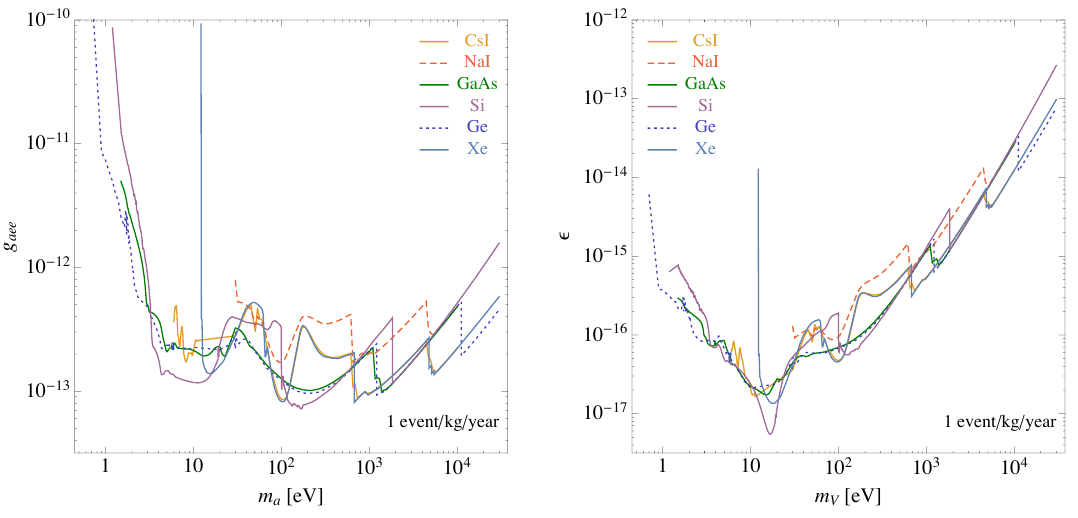
Figure 5 . Couplings needed for 1 event/kg/year for ALPS ( left ) and A 0 ( right ). GaAs and Ge, and Xe and CsI have very similar behaviors due to similar refractive